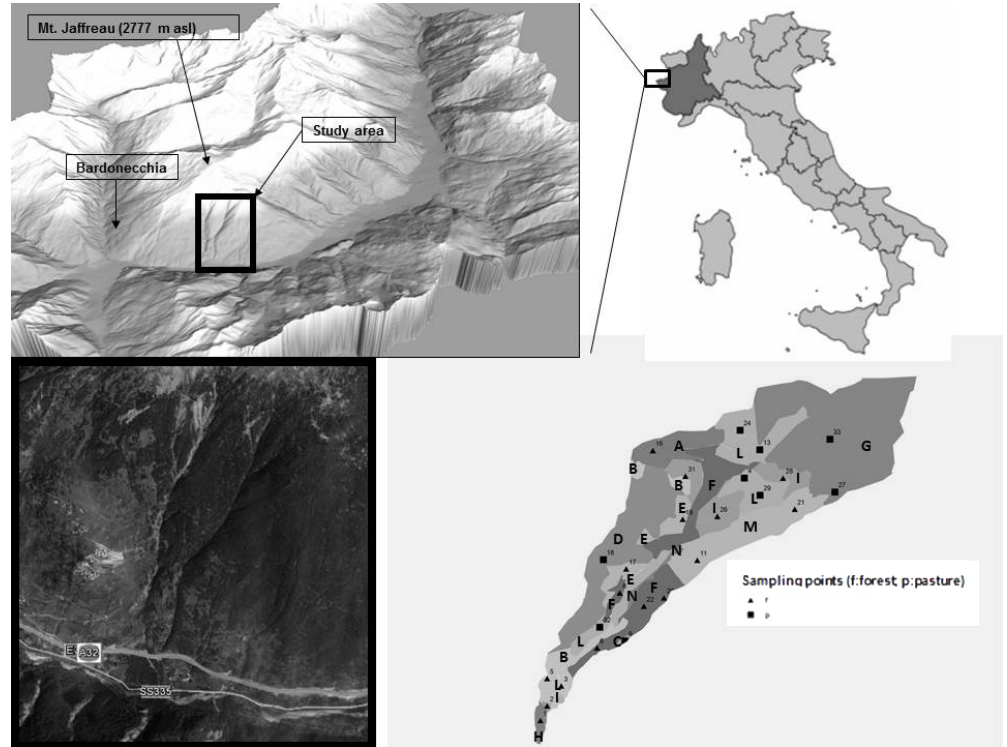
Figure 1. Digital elevation model of the study area (top left); catchment location (top right); Google Earth picture of the area (bottom left); LUT map (bottom